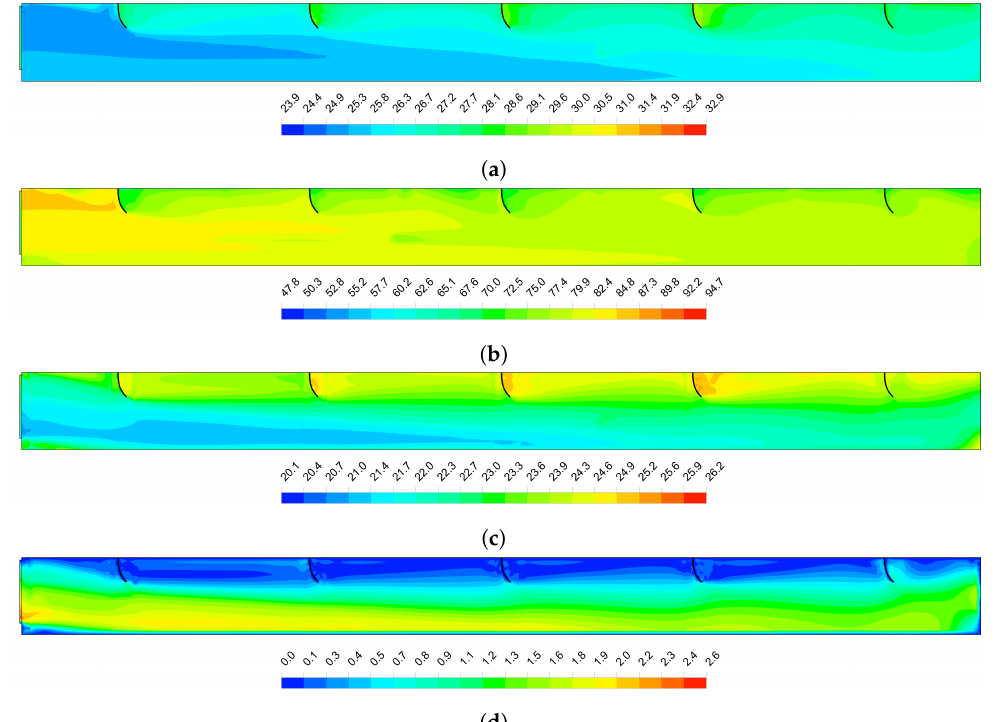
Figure 11. Distribution of air thermal variables analysed along the centre of the tunnel-ventilated compost-packed bedded dairy barn. ( a )— Dry-bulb temperature ( ◦ C). ( b )—Relative humidity (%). ( c )—Equivalent Temperature Index for dairy Cattle (ETIC, ◦ C). ( d )—Air velocity (m s − 1 ). The airflow direction is from left to